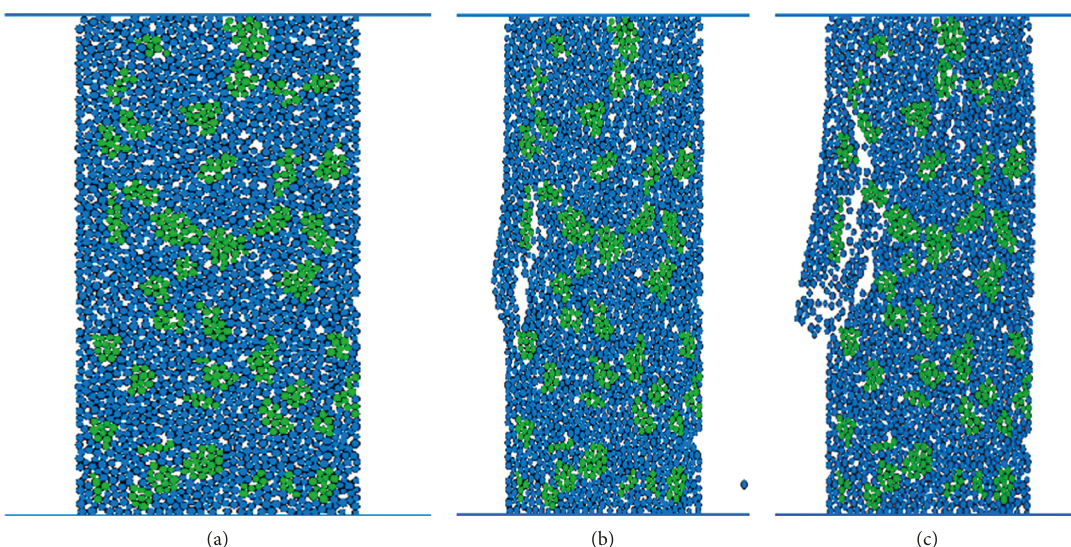
Figure 5: Single-axial compression failure model of SMA-13 asphalt mixture: (a) initial load model; (b) medium load model; (c) final load